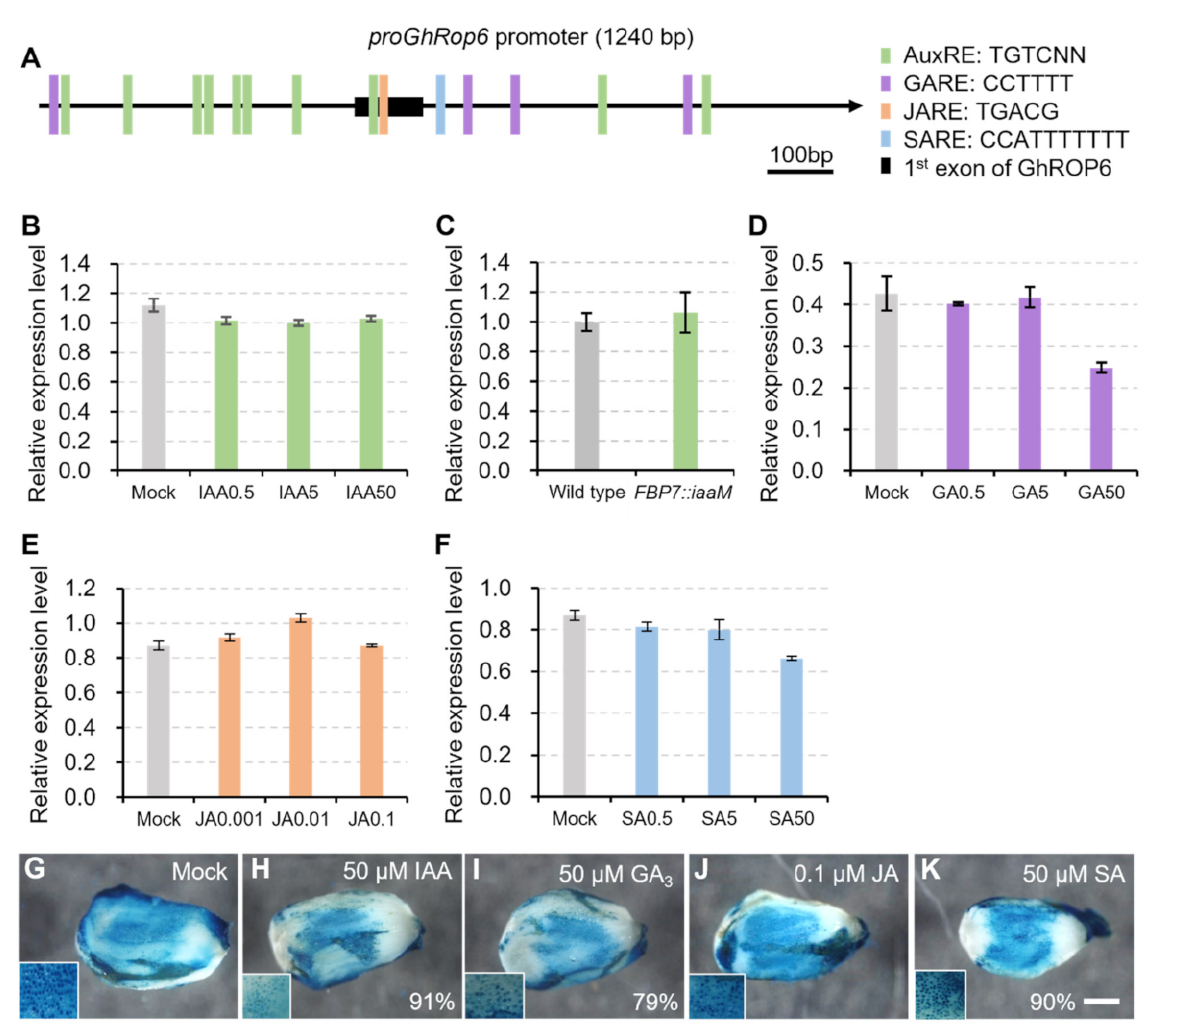
Figure 6. Activity of GhROP6 promoter in response to different plant hormones. ( A ) Response elements for different plant hormones in the GhROP6 promoter region. ( B ) Transcription level of GhROP6 in wild-type ovules treated with different concentration of IAA. ( C ) Transcription level of GhROP6 in FBP7::iaaM and wild-type ovules. ( D ) Transcription level of GhROP6 in wild-type ovules treated with different concentration of GA 3 . ( E ) Transcription level of GhROP6 in wild-type ovules treated with different concentration of MeJA. ( F ) Transcription level of GhROP6 in wild-type ovules treated with different concentration of SA. Transcription level (in arbitrary units) was normalized to that of GhHIS3 . Error bars represent standard deviation of three repeats. ( G – K ) GUS staining in proGhROP6::GUS transgenic ovules after treatment with different plant hormones. Over twenty ovules of transformant #1 were harvested for each treatment. Percentage of ovules with reduced GUS staining are shown. GUS staining of ovules in the lower concentrations were indistinguishable from the control. Insets show enlargement of ovule surface. The scale bars represent 500 µ m. Ovules at 0 DPA, except for those in ( C ), were treated with different plant hormones for 6